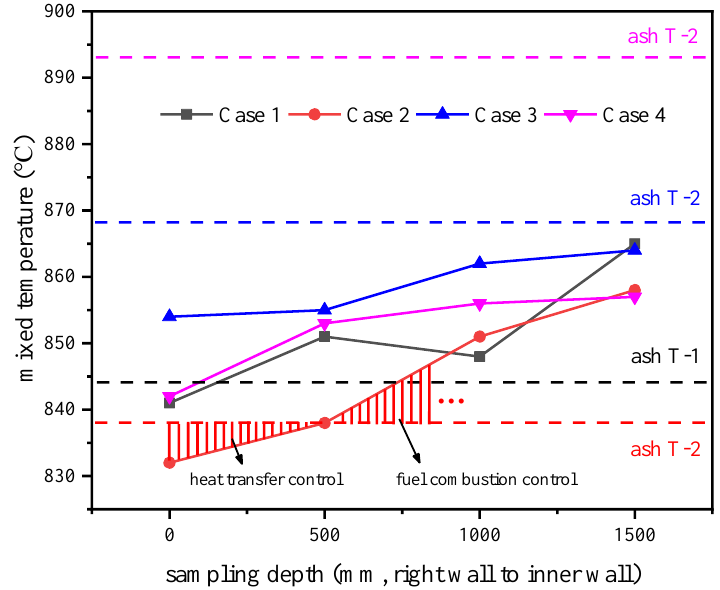
Figure 6. Distributions of mixed bed temperature along the horizontal direction of the lower measurement port at various cases.